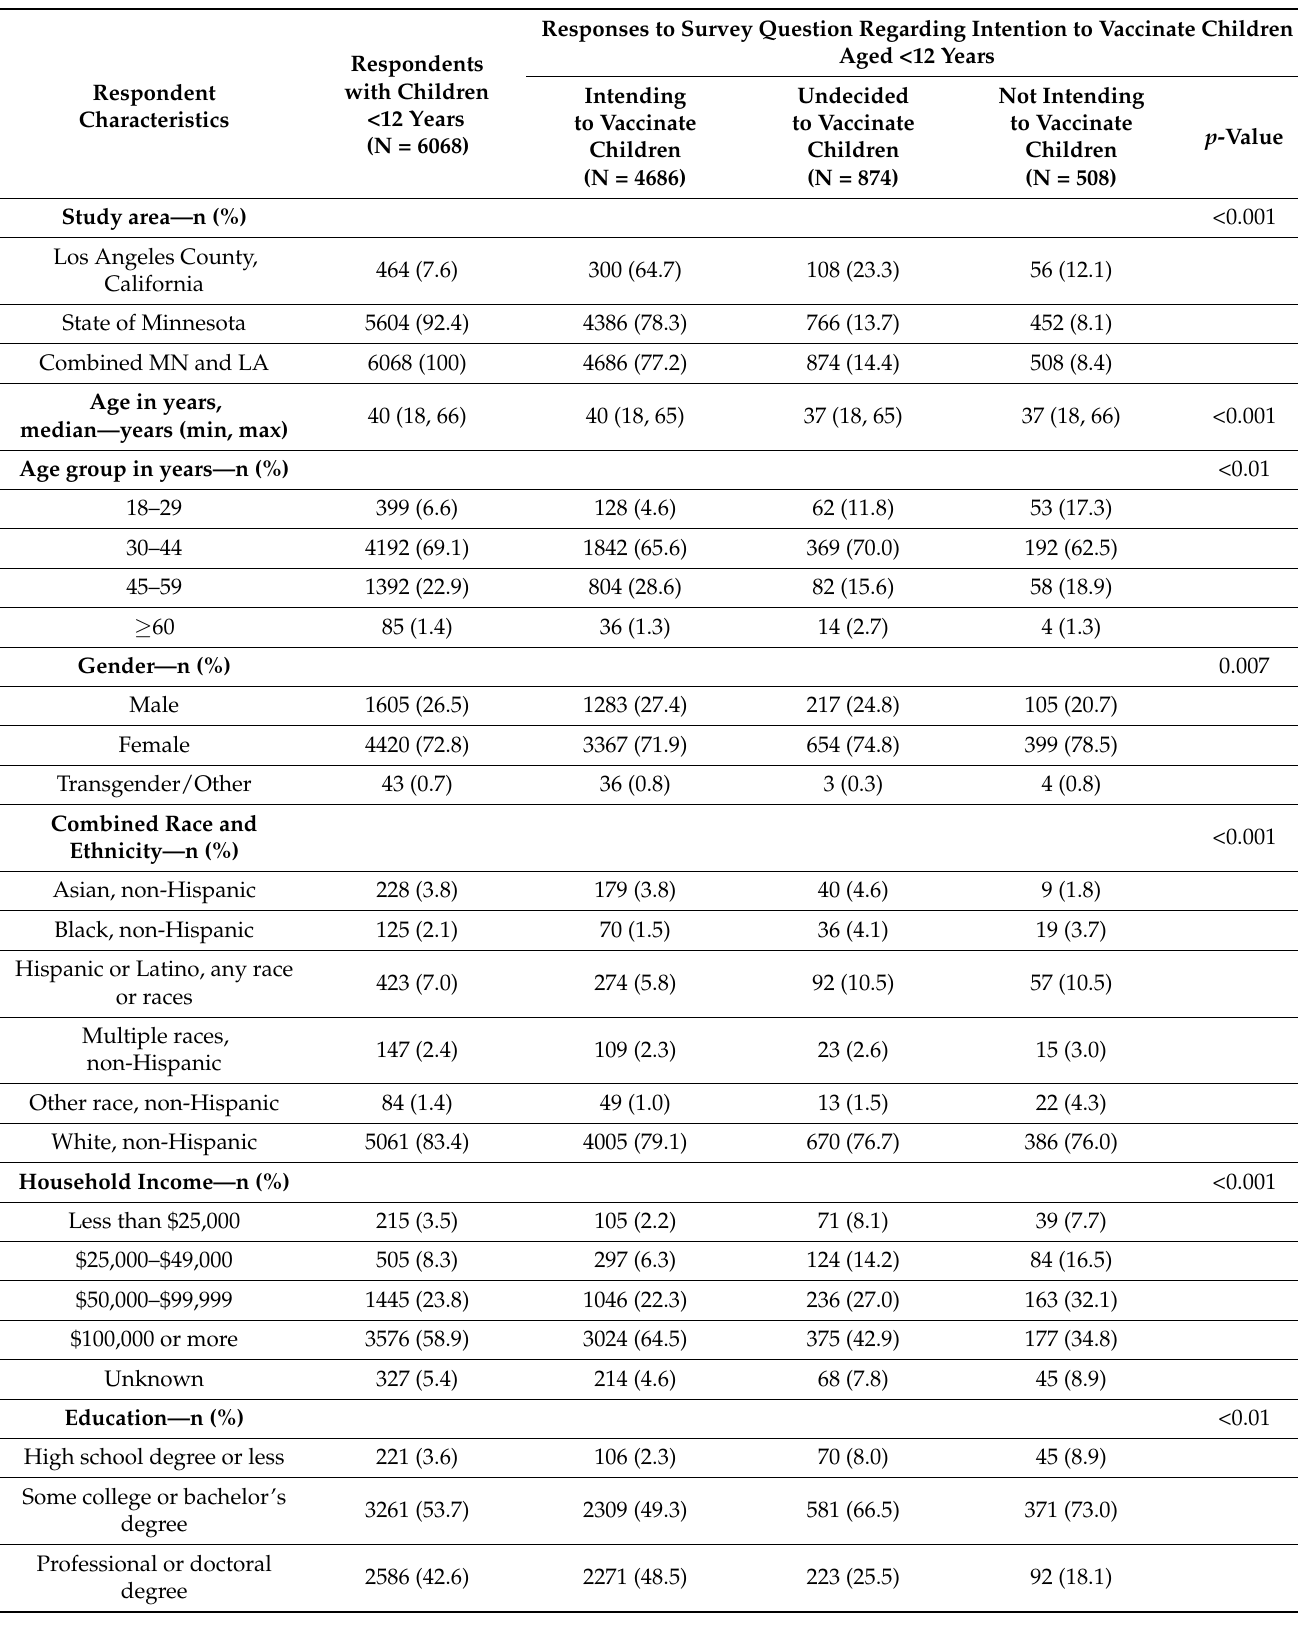
Table 1. Demographic and social characteristics of parents by vaccination intent